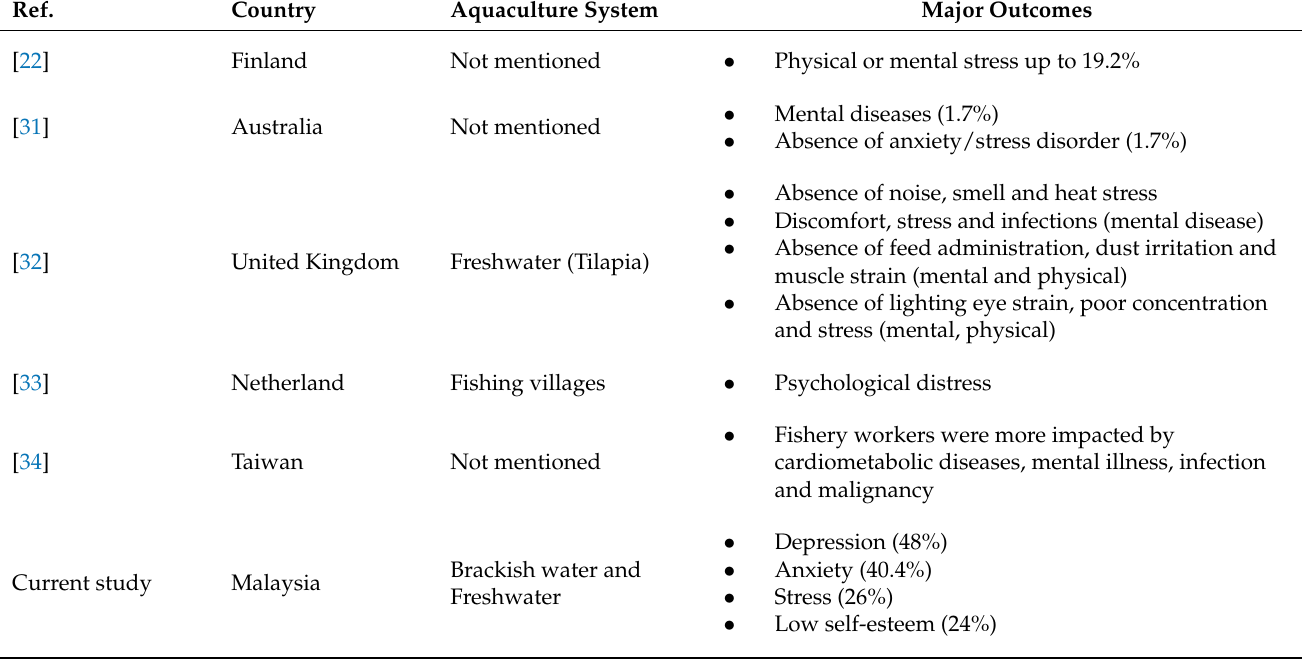
Table 1. Relationship between aquaculture activity and mental health